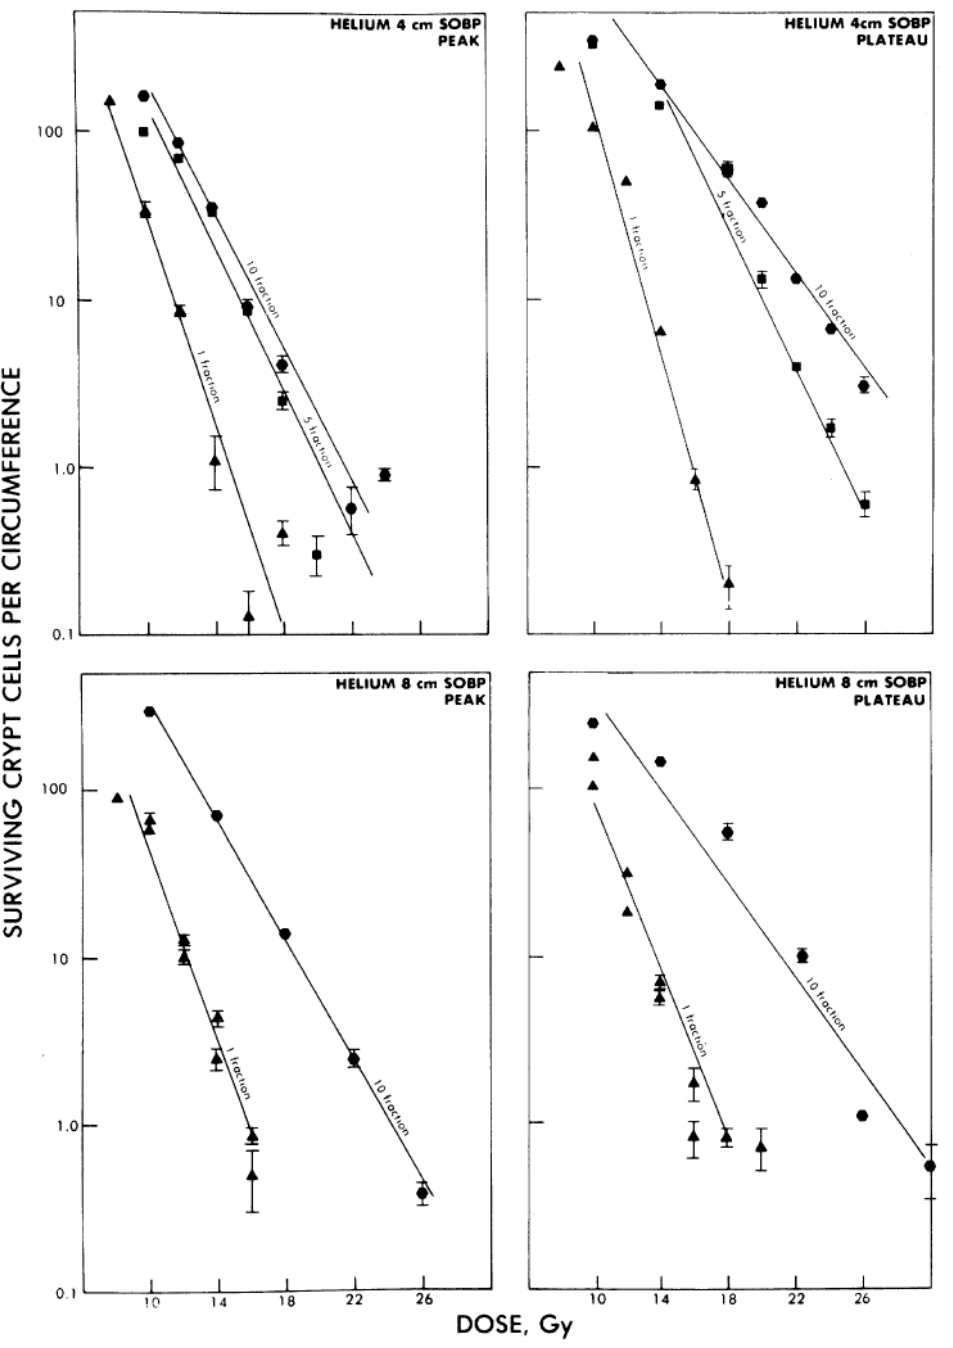
Figure 3. Cell survival curves of jejuna crypt cells irradiated with single dose or fractionated doses (5 fractions or 10 fractions) of SOBP or plateau region of a 225-MeV/amu helium beam. Fractionation clearly enhanced the peak-to-plateau RBE ratio. Adapted from Goldstein LS et al. Radiation Research , 1981; 86, 542–558. Reproduced with permission of the Radiation Research